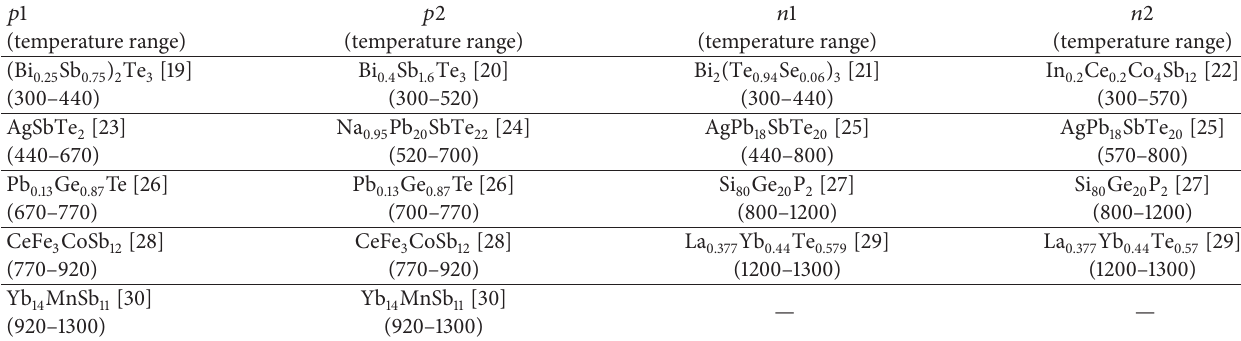
Table 1: The materials of the proposed arrangements and their operation temperature